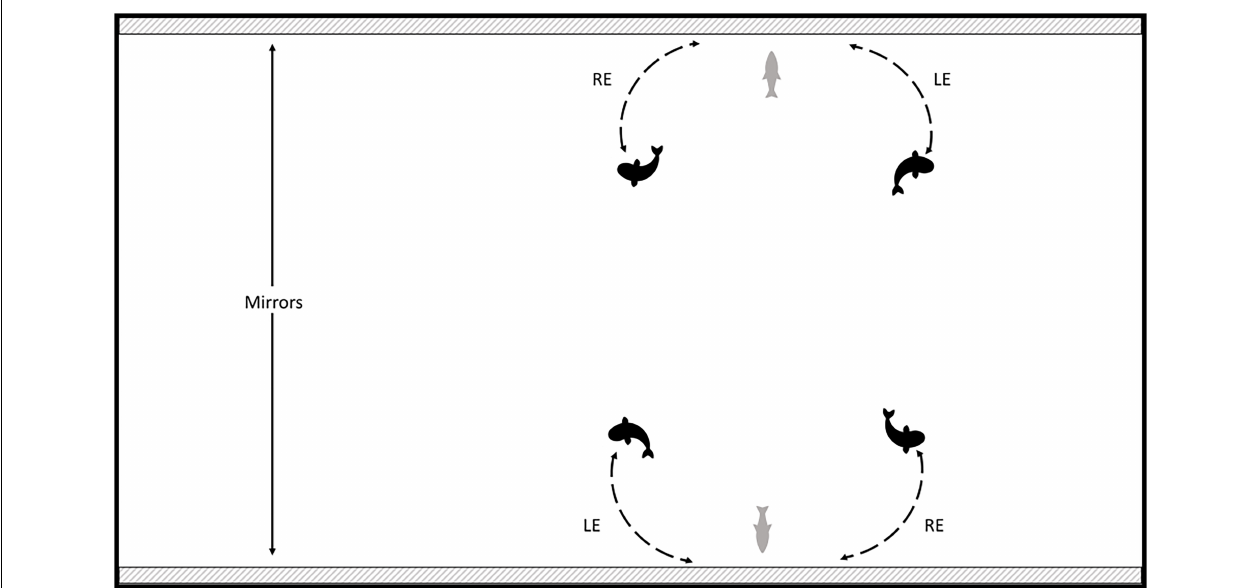
FIGURE 1 | Qualifications for calculating laterality index based on ocular use with closest mirror. LE is left eye use, and RE is right eye use. The gray fish in the middle indicates no specific eye use.